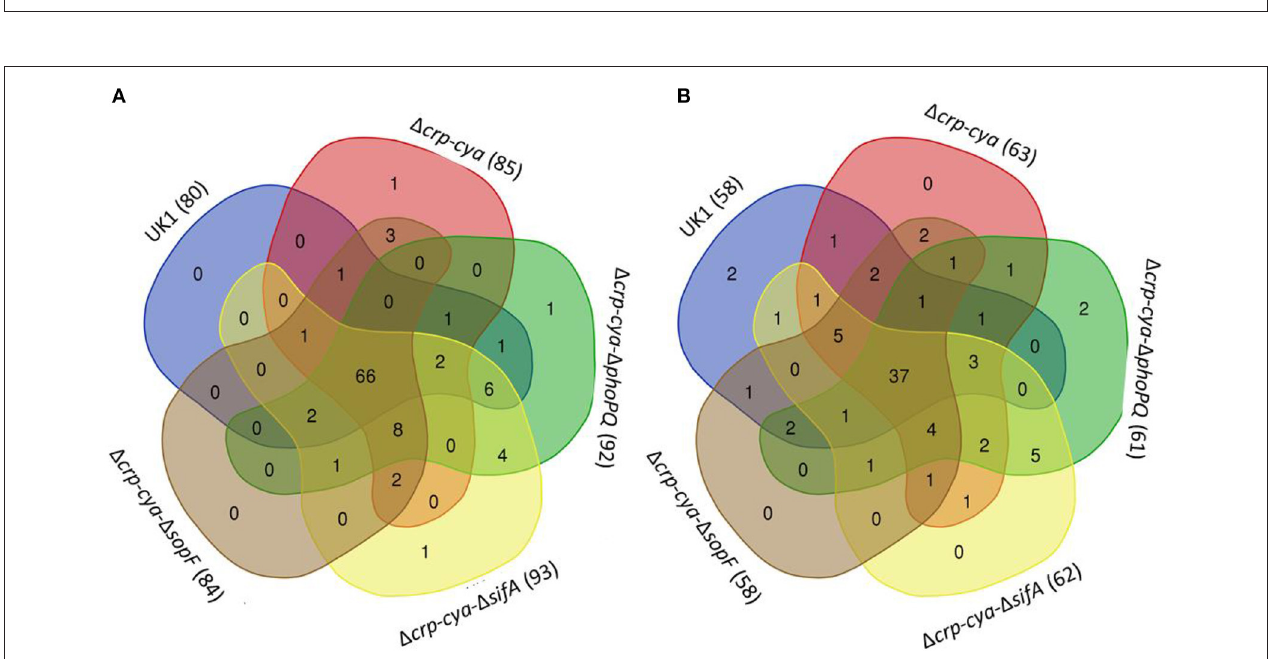
FIGURE 7 | Comparison of the gene expression in S. Typhimurium UK1, 1 crp - 1 cya and its derivatives. (A) Venn diagram showing the overlap of genes upregulated in macrophages infected with UK1, 1 crp - cya , 1 crp - cya - 1 phoPQ , 1 crp - cya - 1 sifA and 1 crp - cya - 1 sopF . The numbers in the bracket next to the strain name indicate the total number of genes upregulated. (B) Venn diagram showing the overlap of genes downregulated in macrophages infected with UK1, 1 crp - cya , 1 crp - cya - 1 phoPQ , 1 crp - cya - 1 sifA and 1 crp - cya - 1 sopF . The numbers in the bracket next to the strain name indicate the total number of genes downregulated.